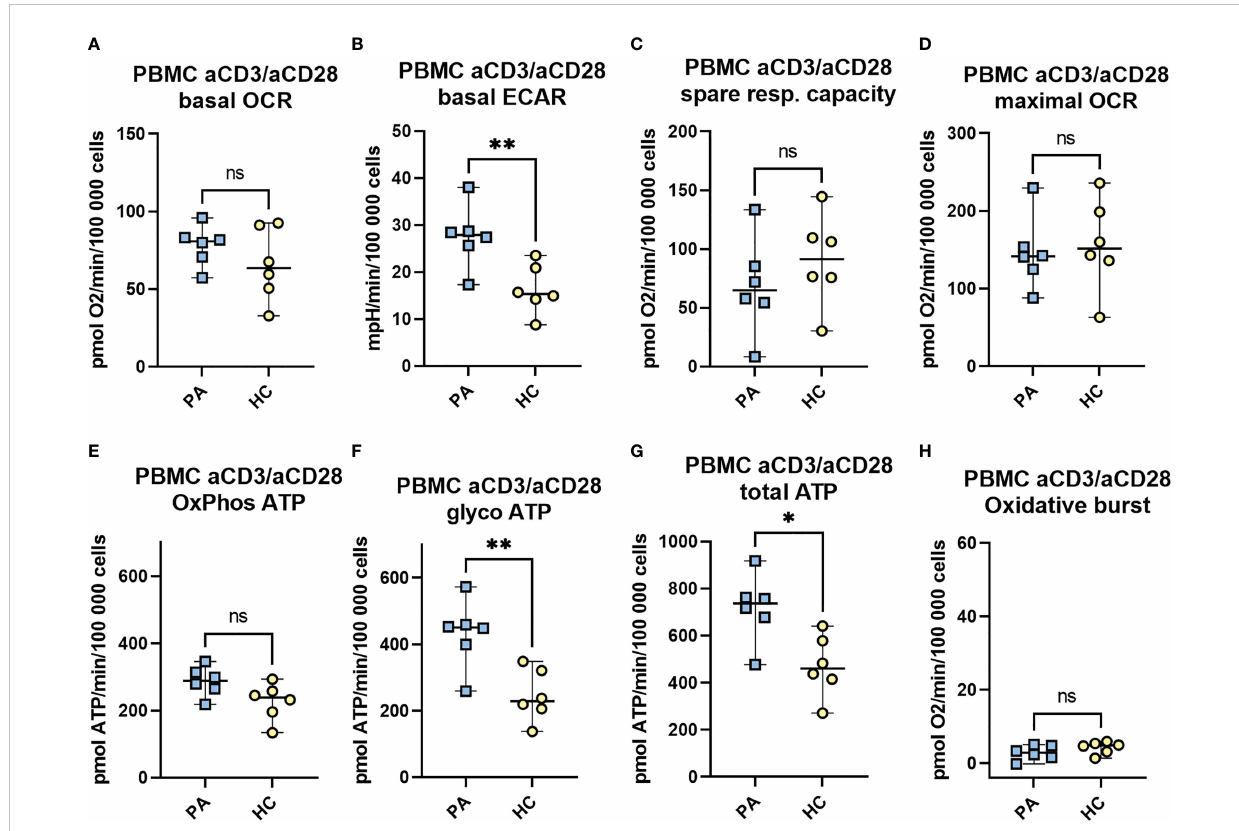
FIGURE 6 The metabolic pro fi le and the mitochondrial function of aCD3/aCD28 activated PBMCs in convalescent phase. Isolated PBMCs of MIS-C patients in convalescent phase (PA, n = 6) and healthy controls (HC, n = 6) were seeded at a density of 10 6 cells/mL in RPMI medium with 10% FBS and stimulated with CD3 and CD28 antibodies. Following 48h incubation, cells were seeded on a Seahorse plate at a density of 3 × (200 000 - 250 000) cells/well and OCR (A) and ECAR (B) were measured with Seahorse XFe24 analyzer under basal conditions, and in response to mitochondrial inhibitors (Mito Stress Assay): oligomycin (1.5 m M), FCCP (2 m M), and antimycin A plus rotenone (0.5 m M). The spare mitochondrial capacity (C) and maximal respiration - maximal OCR (D) were determined according to Mito Stress Assay, OxPhos ATP (E) , glycoATP (F) and total ATP (G) were calculated from OCR and ECAR measurements as de fi ned in M&M. The oxidative burst (H) was measured after last injection with PMA/ionomycin (1 m g/ml). Data are presented as median with 95%CI and analyzed by Mann-Whitney test where *P < 0.05, **P < 0.01, ns, not signi fi cant. OCR, oxygen consumption rate, ECAR, extracellular acidi fi cation